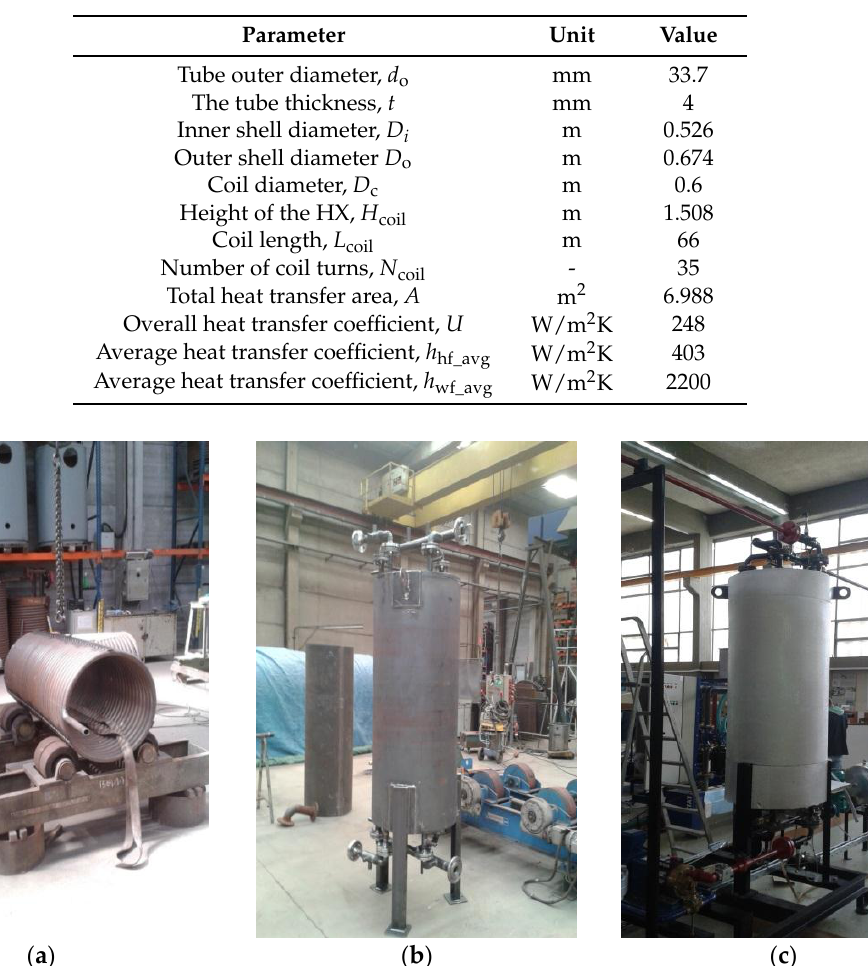
Table 6. Summary of the final geometrical values of the helical coil heat exchanger.